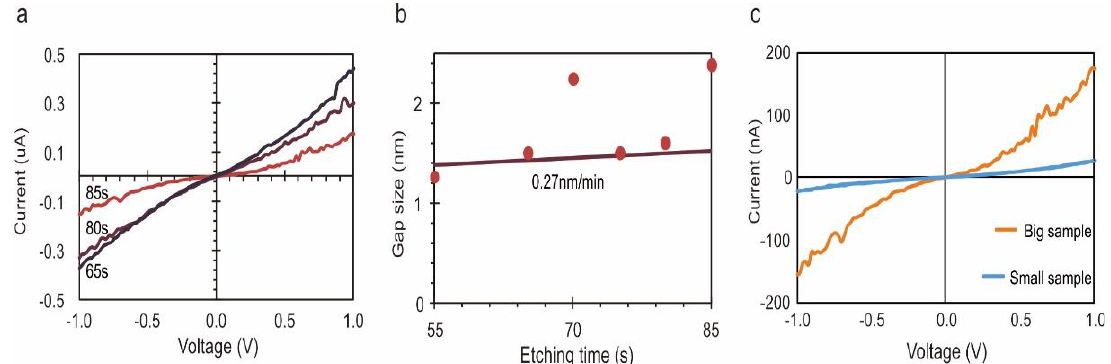
Figure 3. Characterization of the etching process. ( a ) IV for the same tunnel junction at different etching times; ( b ) extracted tunneling gap size from (a) as a function of etching time with overlay of previously observed edge-trimming rate Xie et al. [27]; ( c ) comparison of current-voltage characteristics for two different lateral gap widths but the same gap size.